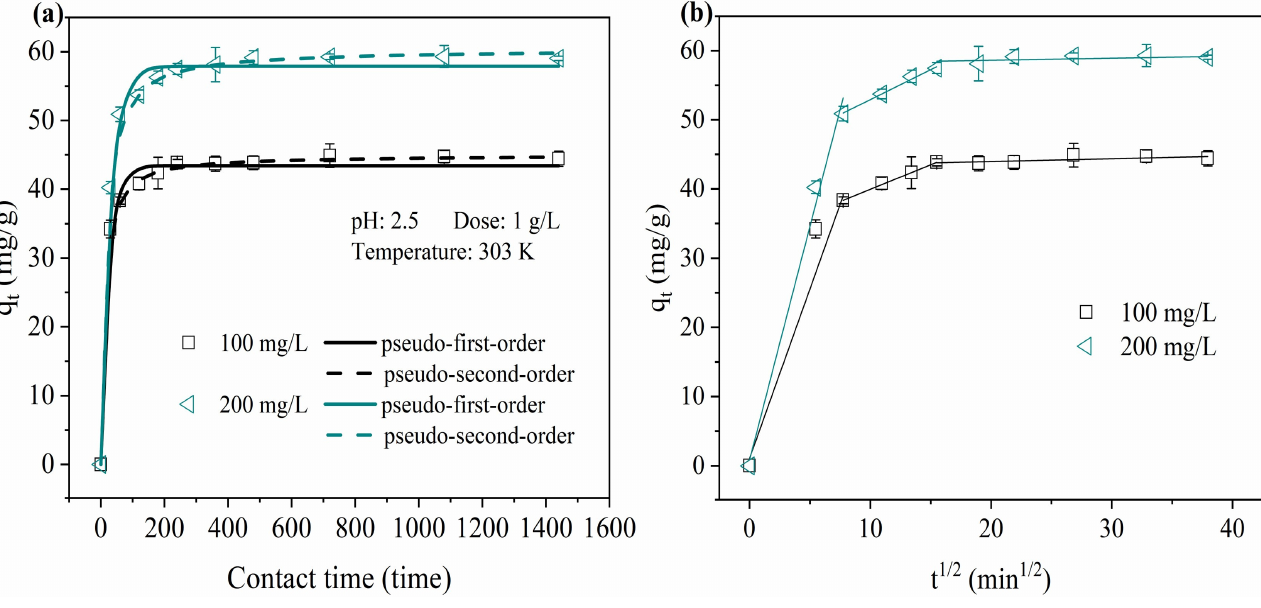
Figure 4. Kinetic profiles of Fe (III) adsorption by PYCS: ( a ) The pseudo-first- and pseudo-second- order kinetic plots. ( b ) The intra-particle diffusion kinetic model.